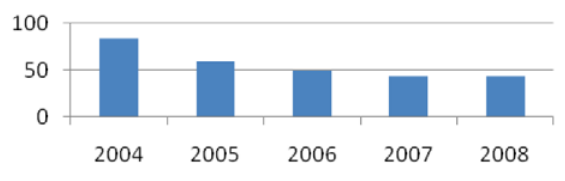
Average commencement numbers of Indigenous students in Australian universities (N = 40) throughout 2004 to 2008. Compiled based on DEEWR data on higher education